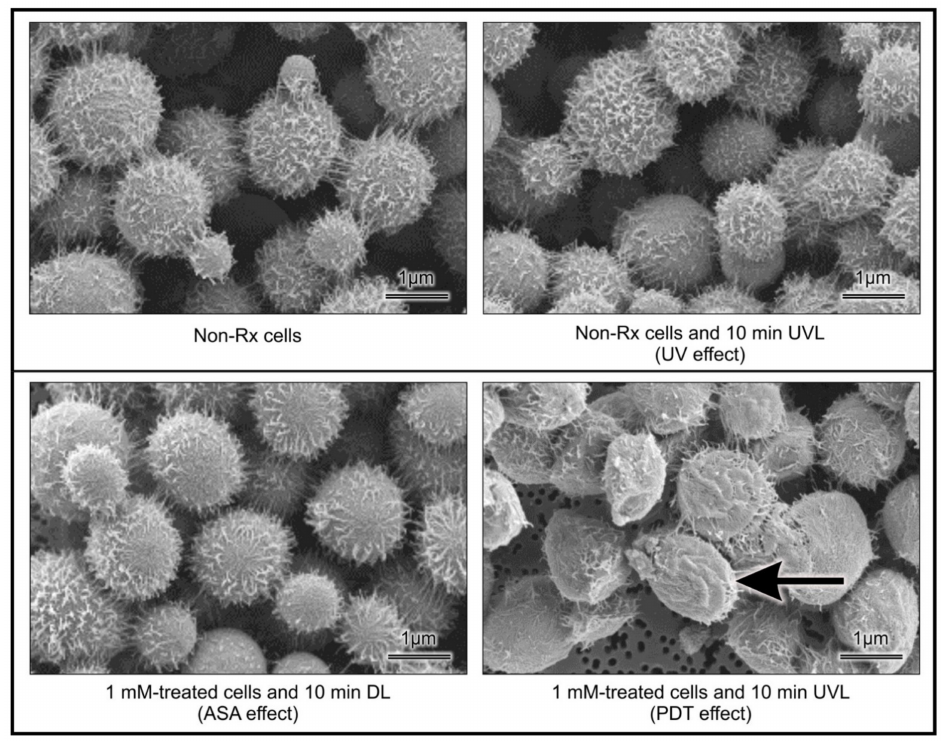
Figure 4. SEM images showing the morphological differences of cryptococcal cells’ ultrastructure after being handled in designed experimental groups. The arrow points at cells which exemplify the effects of PDT, i.e., a cell that appears wrinkled. The images were taken after studying C. neoformans LMPE 046